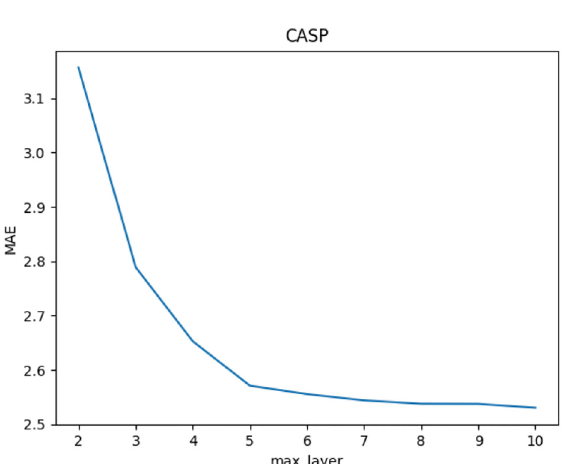
Figure 9. Relation